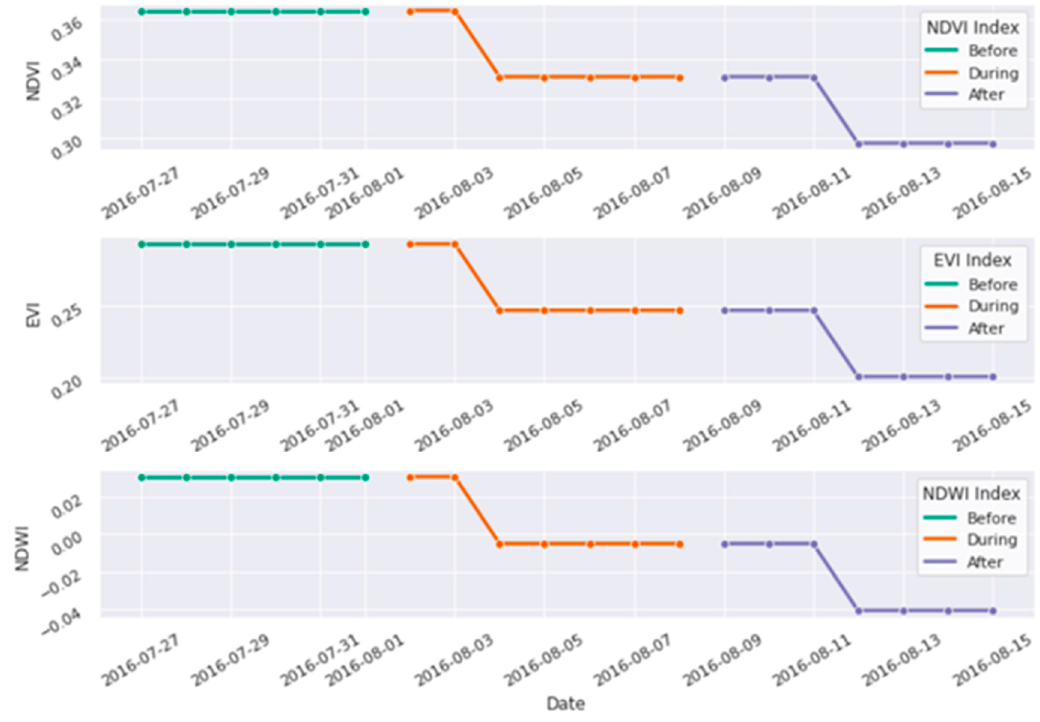
Figure 3. Before, During and After fire, data w.r.t. vegetation indices for a grid cell id#25 in 2016.